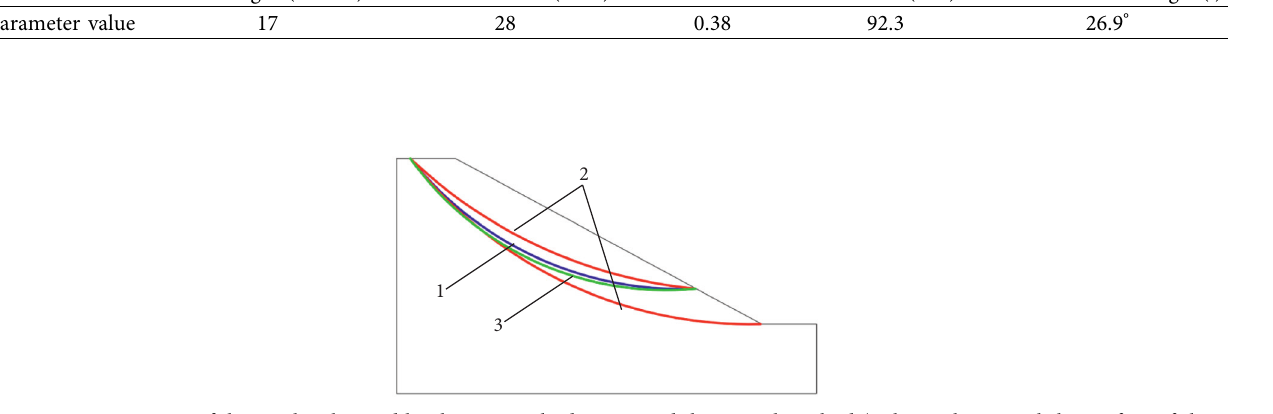
Figure 6: Comparison of the results obtained by the test method, FEM, and theoretical method (1 shows the critical slip surface of slope obtained by the simple penetration test, 2 shows the potential slip surface of slope calculated by FEM, and 3 shows the potential slip surface of slope obtained by theoretical